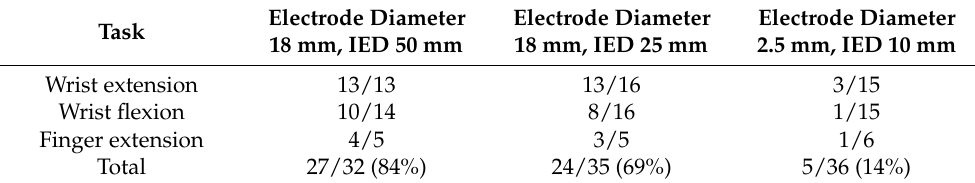
Table 4. Occurrence of crosstalk in the brachioradialis (BRD) muscle during wrist flexion and exten- sion tasks when sEMG is detected, from the BRD, using electrodes of different size and interelectrode distance. Absence of fine wire EMG in the BRD was used as the gold standard to determine the presence of crosstalk in the surface